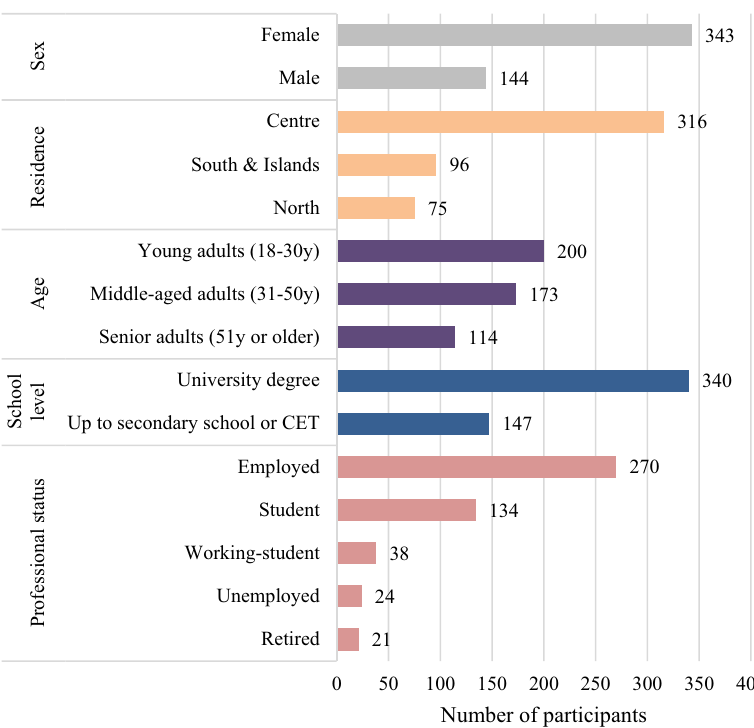
Figure 1: Sociodemographic characterization of the sample ( N = 487 )